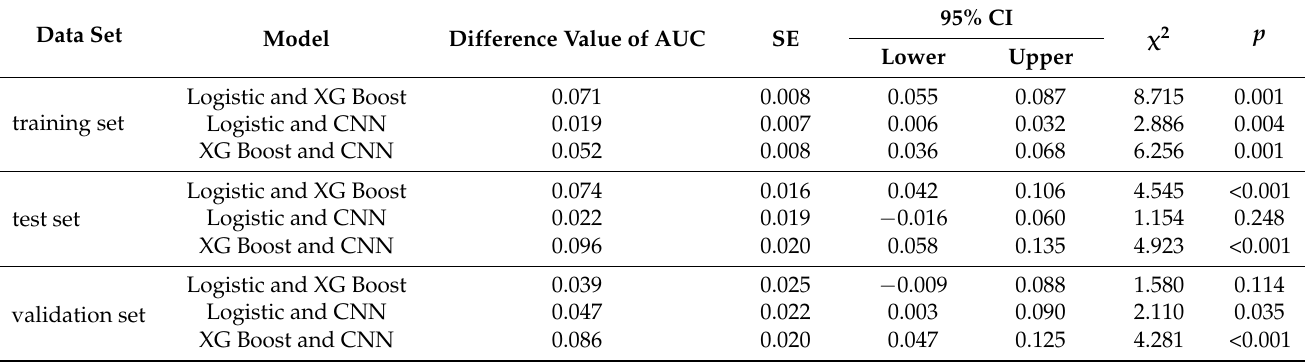
Table 8. AUC comparison of three models.